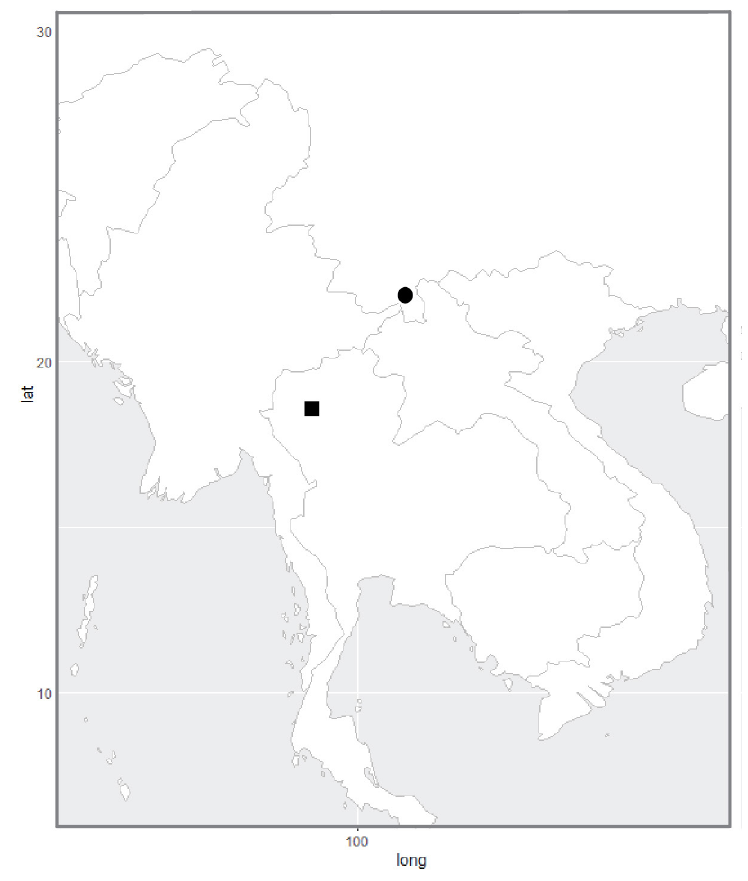
Fig. 8. Map of mainland Southeast Asia, showing the collecting sites of Zhang et al. (2011) ( Hahnia saccata Zhang, Li & Zheng, 2011 and Hexamatia senaria (Zhang, Li & Zheng, 2011) gen. et comb. nov.), circle; and our new hahniid specimens ( Hexamatia seekhaow gen. et sp. nov., Hahnia ngai sp. nov. and Hahnia saccata ),